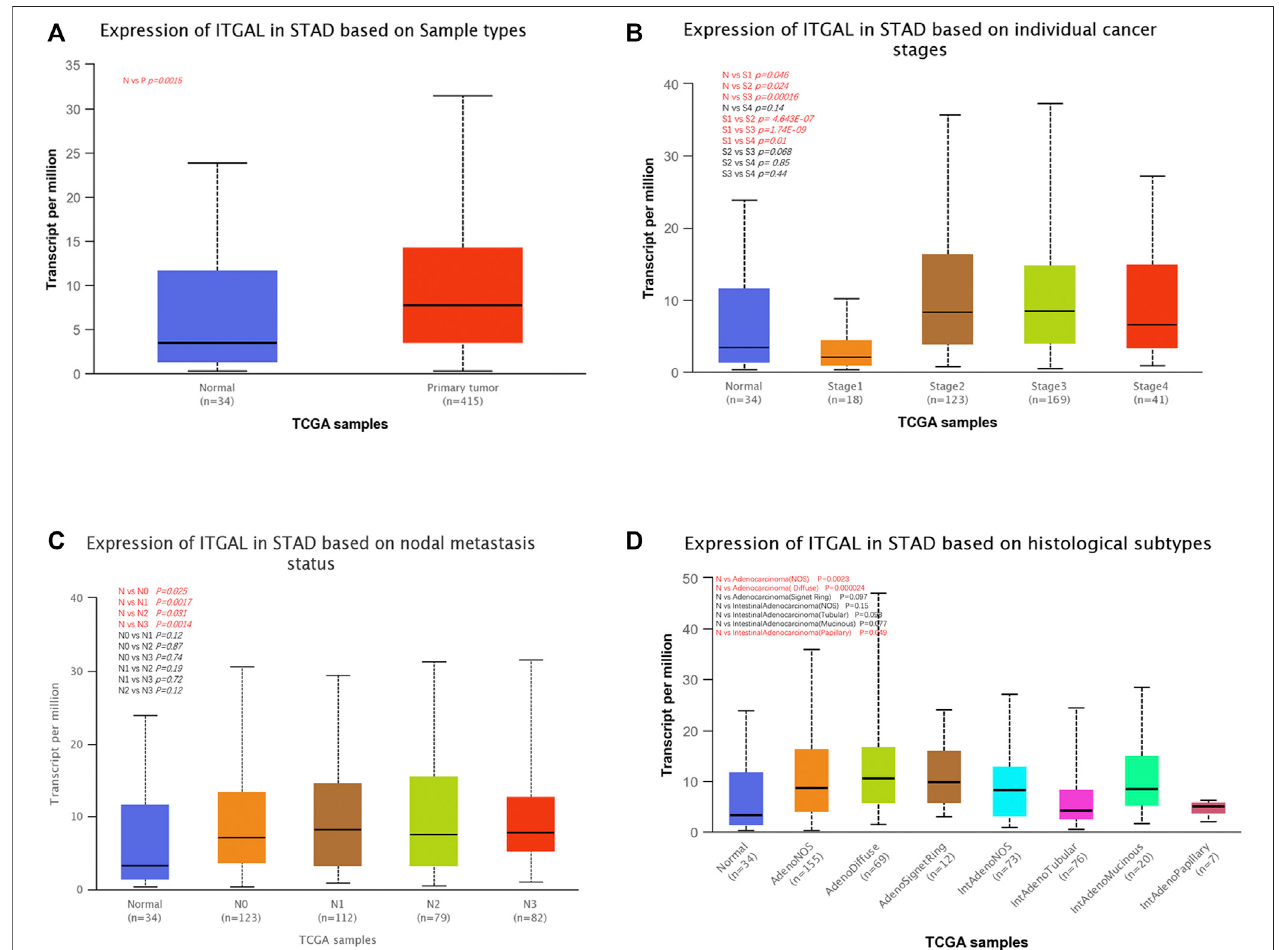
FIGURE 2 | Correlation between ITGAL mRNA expression level and clinicopathological parameters of gastric cancer through the UALCAN database. (A) Sample type (normal/primary tumor). (B) Cancer stage (stage 1, 2, 3, and 4). (C) Lymph node stage (N0 1, 2, and 3). (D) Gastric cancer subgroup. N, normal; P, primary tumor; S1, stage 1; S2, stage 2; S3, stage 3; S4, stage 4; STAD, stomach adenocarcinoma.